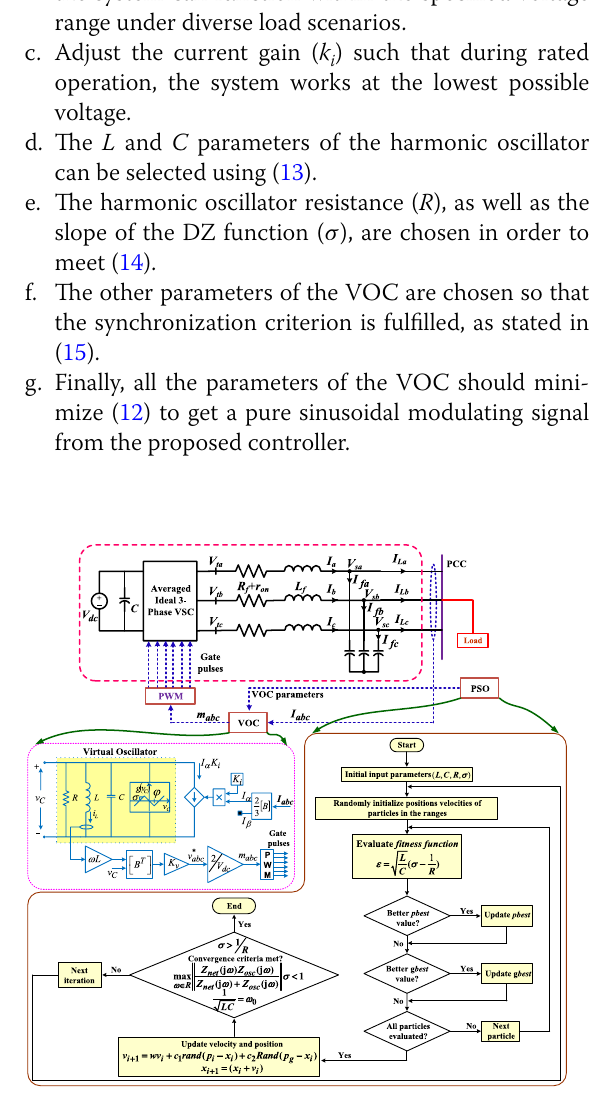
Fig. 8 Schematic of VOC-PSO implementation and flow chart of the PSO process